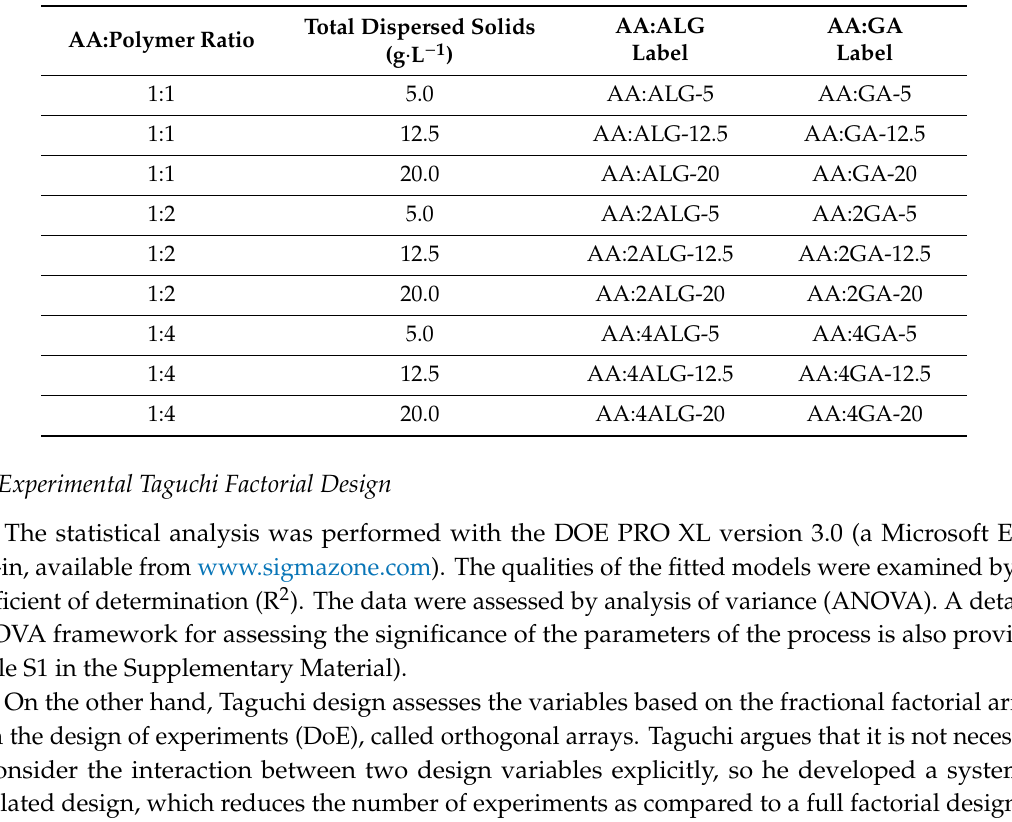
Table 1. Taguchi L 9 orthogonal array for L-ascorbic acid encapsulation